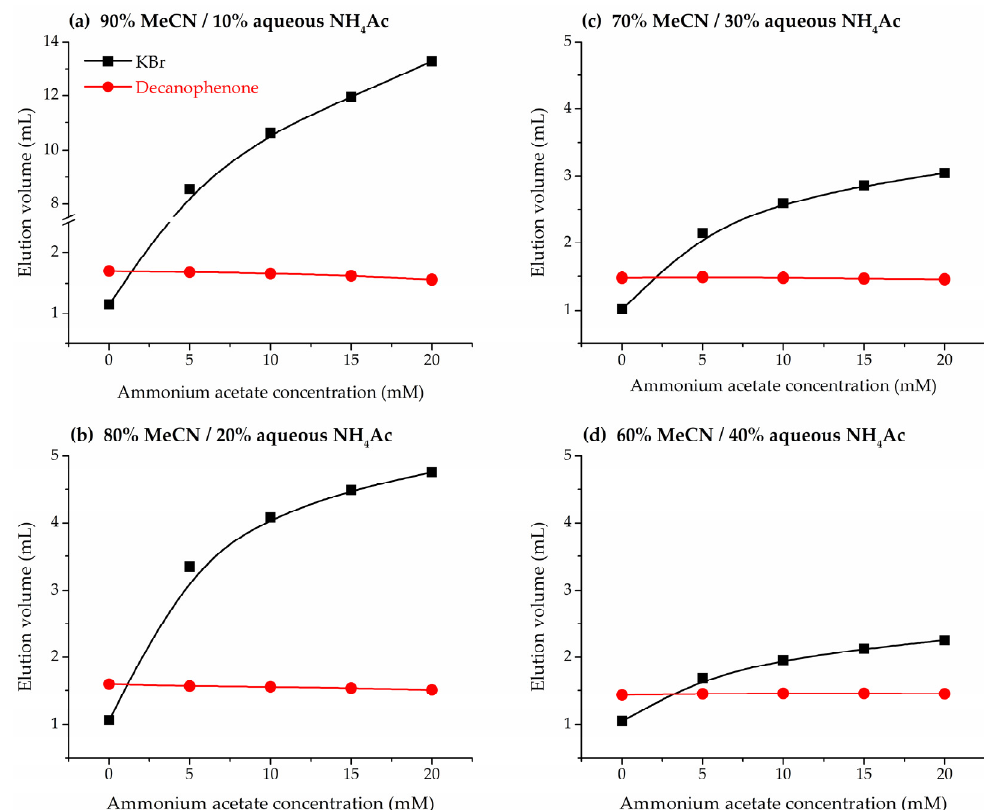
Figure 4. Variation of elution volumes of potassium bromide (black squares) and decanophenone (red dots) with the ammonium acetate concentration and the amount of acetonitrile (MeCN) in the mobile phase. Acetonitrile/aqueous buffer mixtures: ( a ) 90%, ( b ) 80%, ( c ) 70%, and ( d ) 60%.